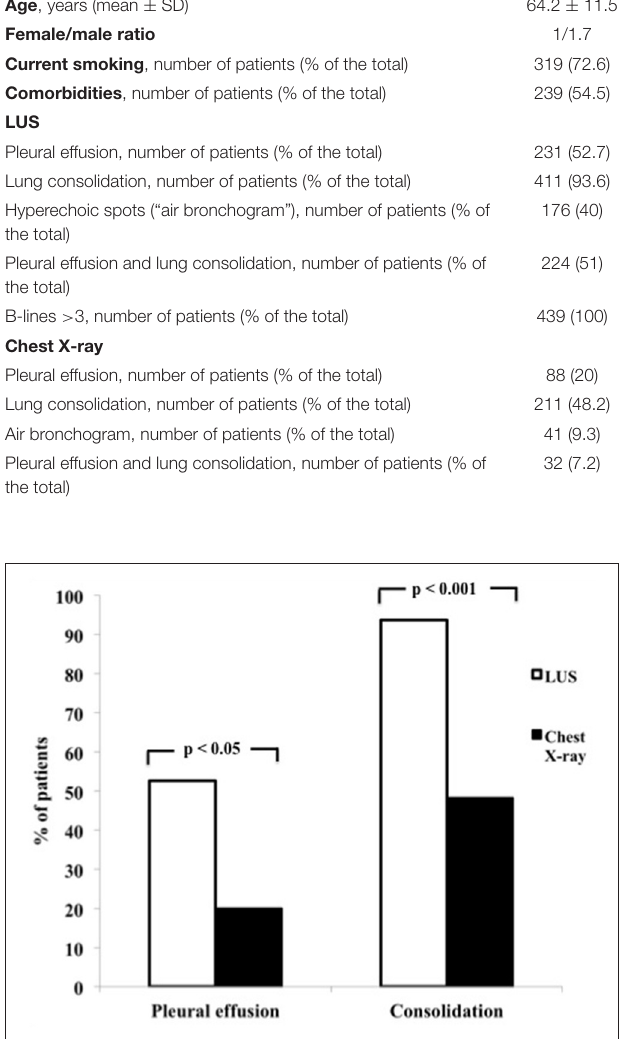
techniques in the percentage of pleural effusion (52.7 vs. 20%, p < 0.05 by McNemar’s test) ( Figure 1 ).